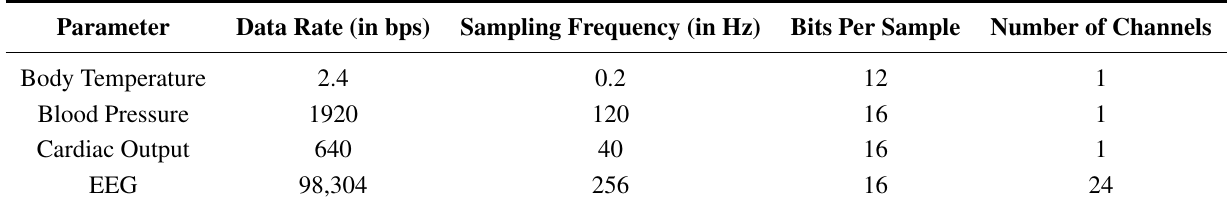
Table 3. Characteristics of representative traffic originated in current healthcare